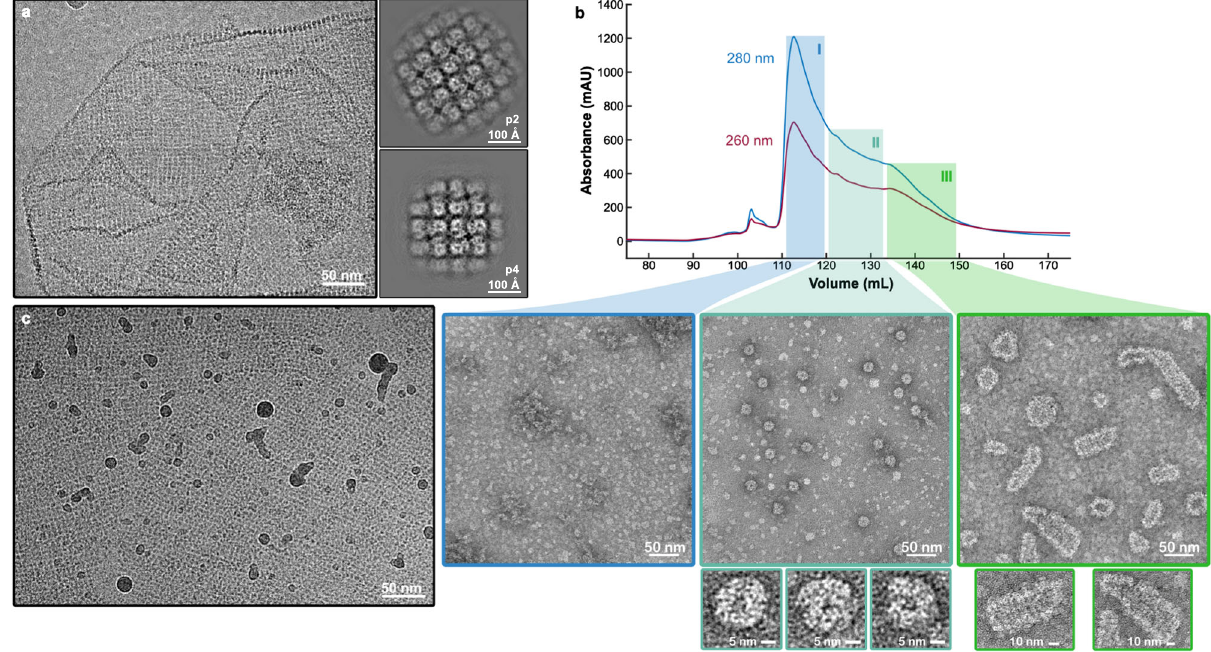
Fig. 1 | PhuN forms a broad range of assemblies. a Micrograph showing an unla- beled phage nuclear shell fragment isolated from Φ PA3 infected wild-type Pseudo- monas aeruginosa alongside the subsequent p2 (120Å, 120° unit cell length, angle) and p4 (110Å, 90° unit cell length, angle) symmetries observed upon 2D classi fi ca- tion. Folds and differences in lattice orientation are visible. ( n =1 unlabeled shell isolationexperiment). b Anionexchangetraceshowingextendedelutionpro fi leand